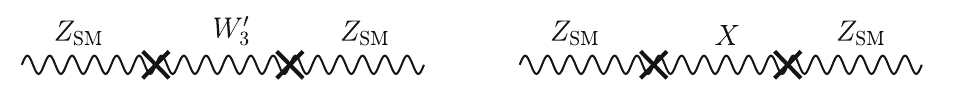
Fig. 1 Tree level diagrams (to second orders of g H and g X ) that contribute to the oblique parameters from the mass mixings (11) between the Z SM , W (cid:3) and X in G2HDM 3